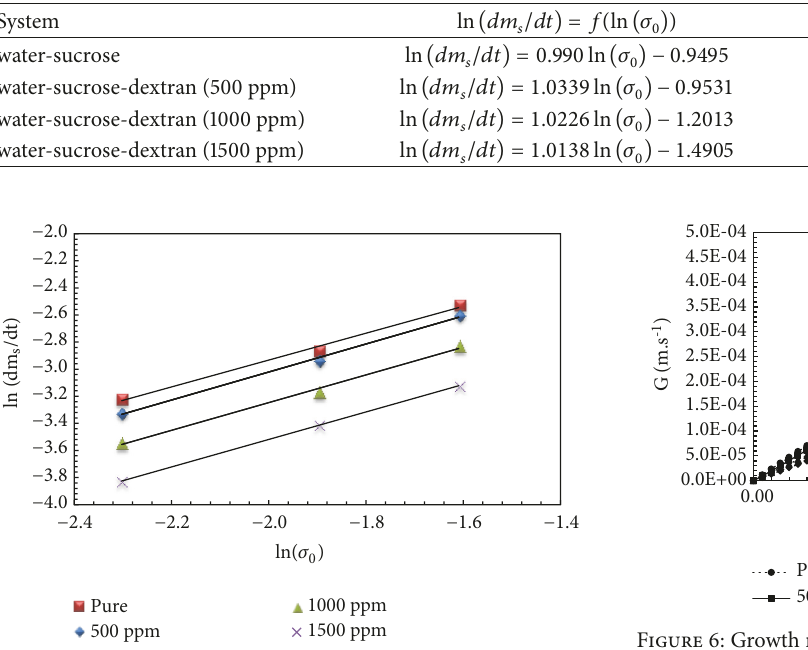
Figure 5: Evolution of mass sucrose crystal over time as function of supersaturation in aqueous solutions without and with dextran.